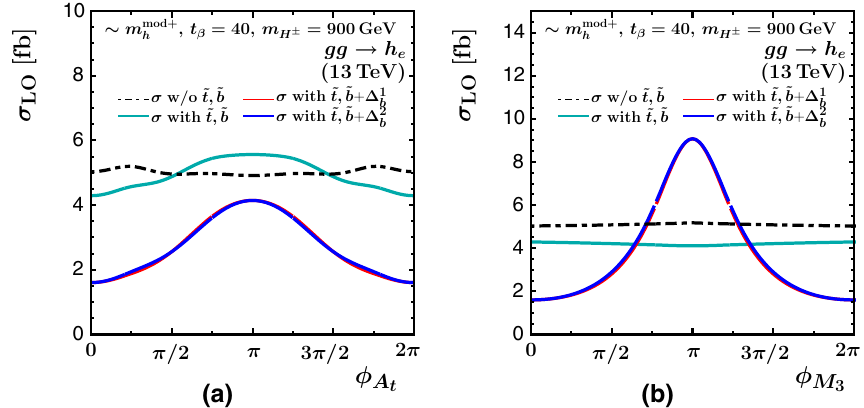
Fig. 9 Effect of (cid:8) b contributions on the LO cross sections of h e as correspond to the prediction where the squark loop contributions at the a function of a φ A and b φ M in the m mod + -inspired scenario with one-loop level are included. In the red ( blue ) curves furthermore the h t 3 tan β = 40. The black dot-dashed curves depict the prediction without simplified (full) resummation of the (cid:8) b contributions is included squark contributions (except through ˆ Z factors), while the cyan lines